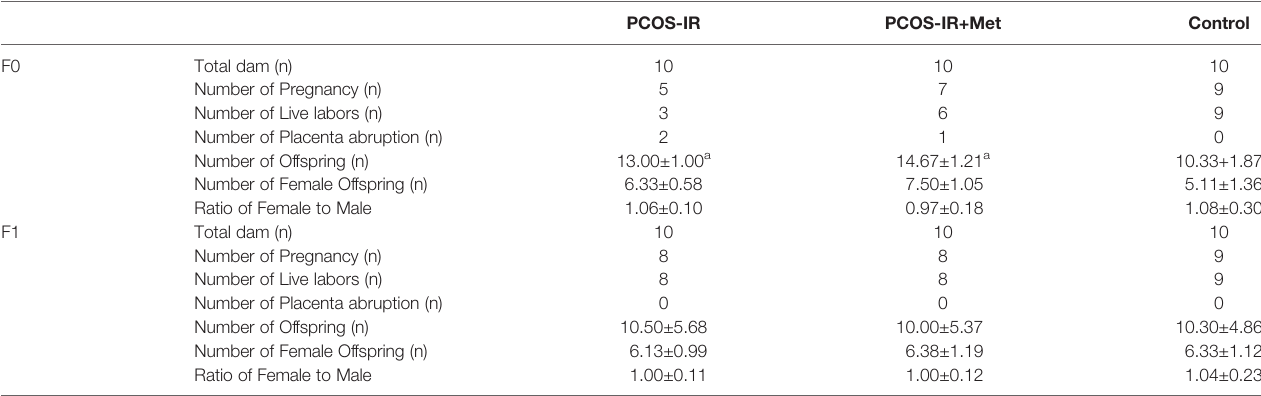
TABLE 2 | The impacts of treatment with metformin on pregnant